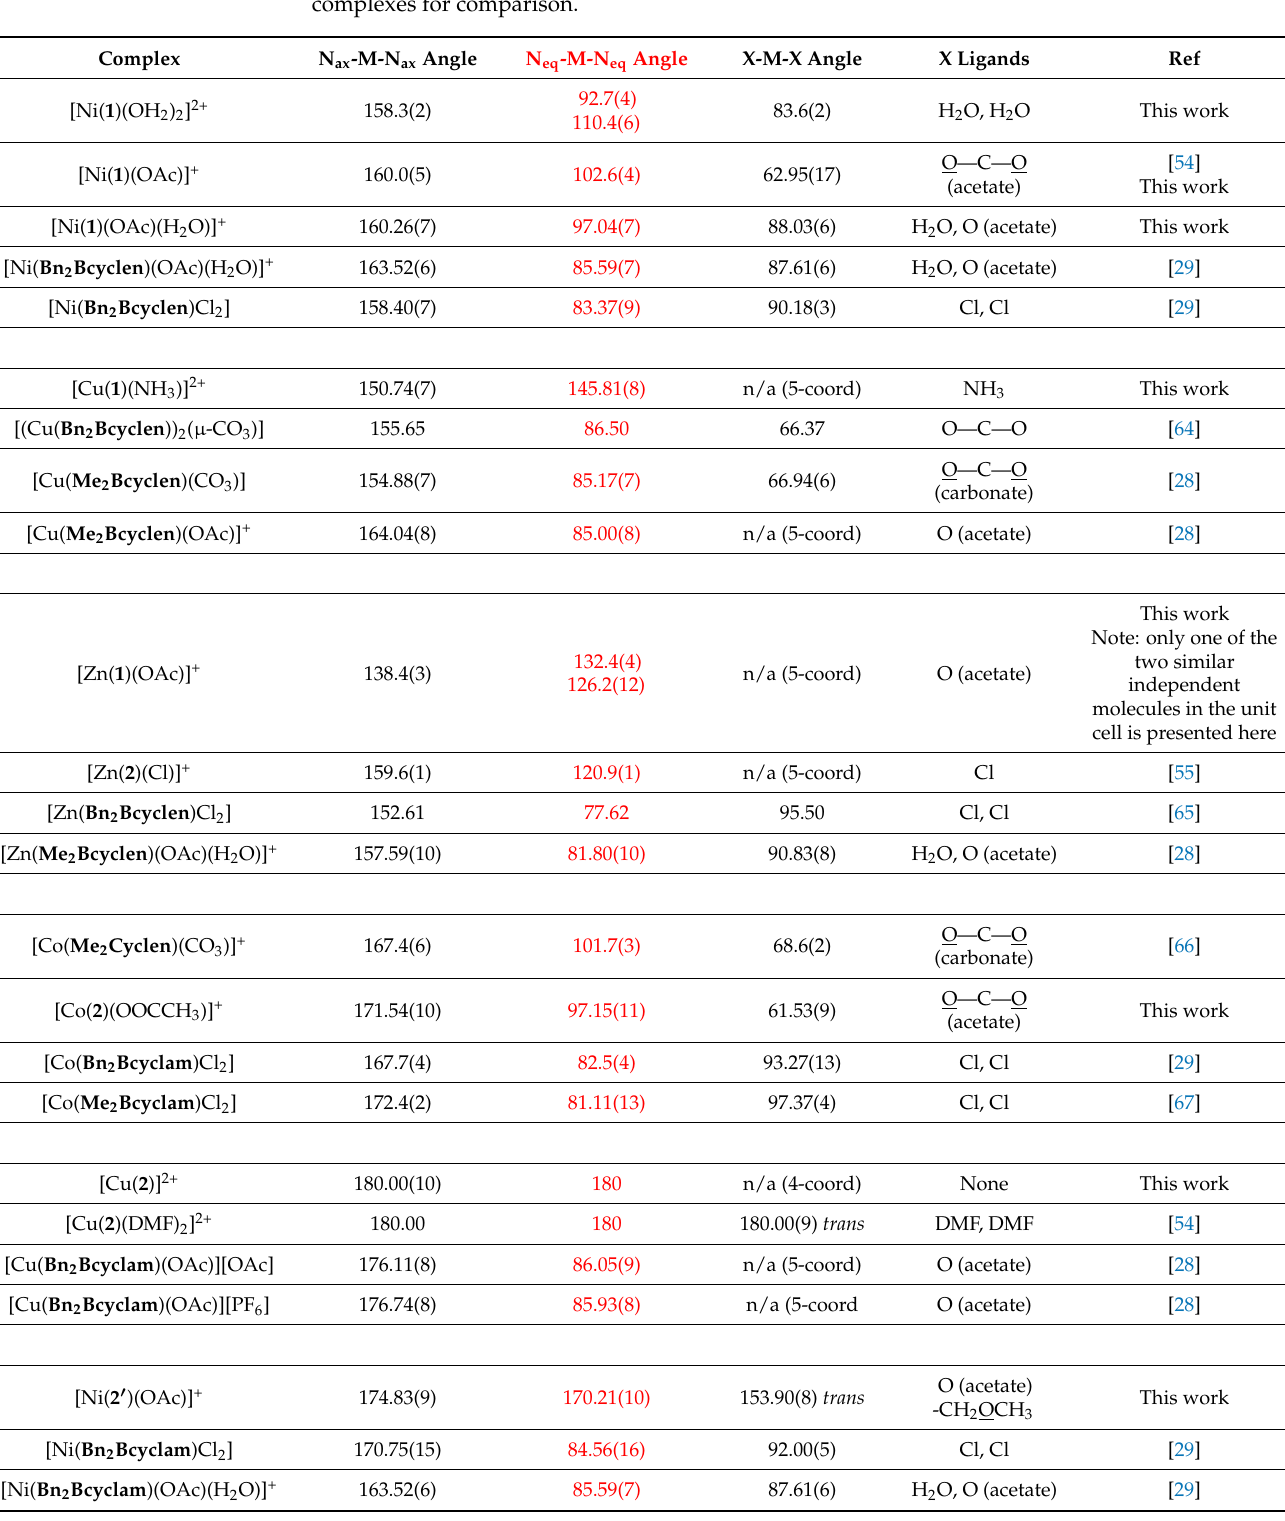
Table 2. N ax -M-N ax and N eq -M-N eq bond angles ( ◦ ) for bridged and unbridged cyclen and cyclam complexes for